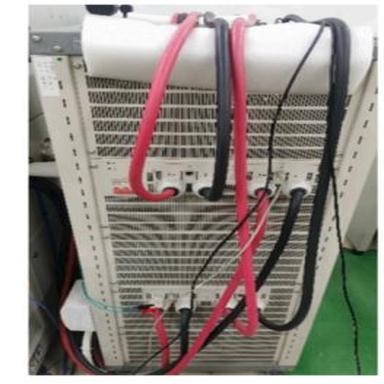
Experimental platform for charge and discharge test.